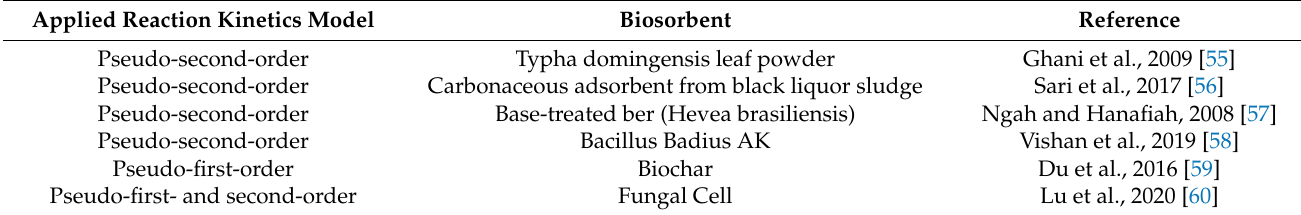
Table 2. Examples of biosorption kinetics on specific